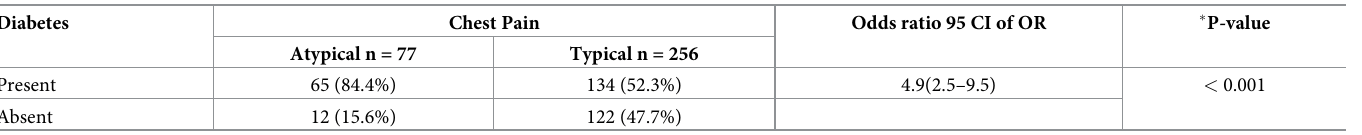
Table 4. Association of diabetes with chest symptoms.